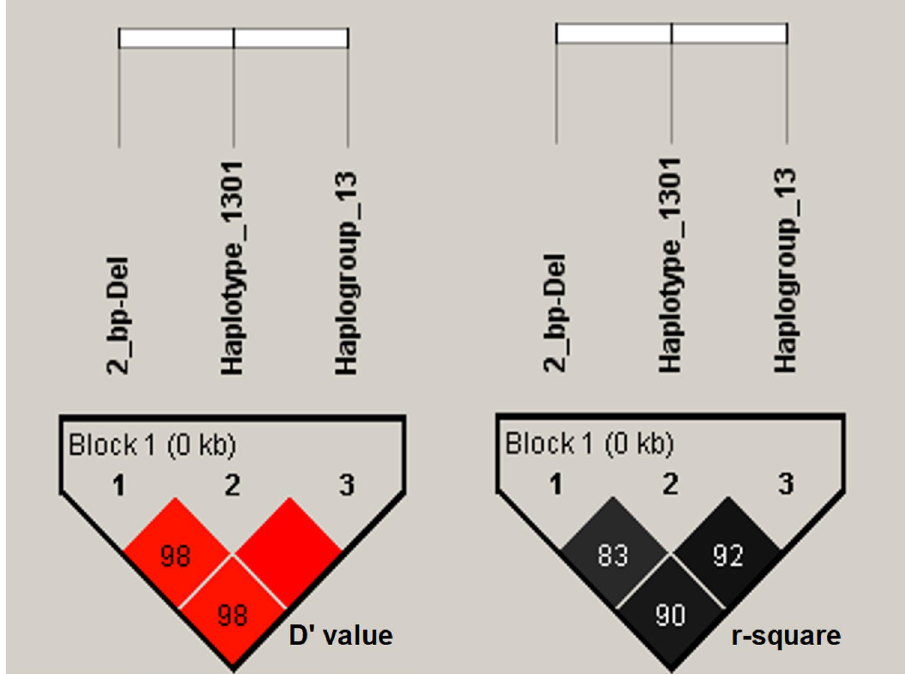
Figure 4. Linkage disequilibrium between 2 bp del variant, haplotype 13:01, and haplogroup 13.